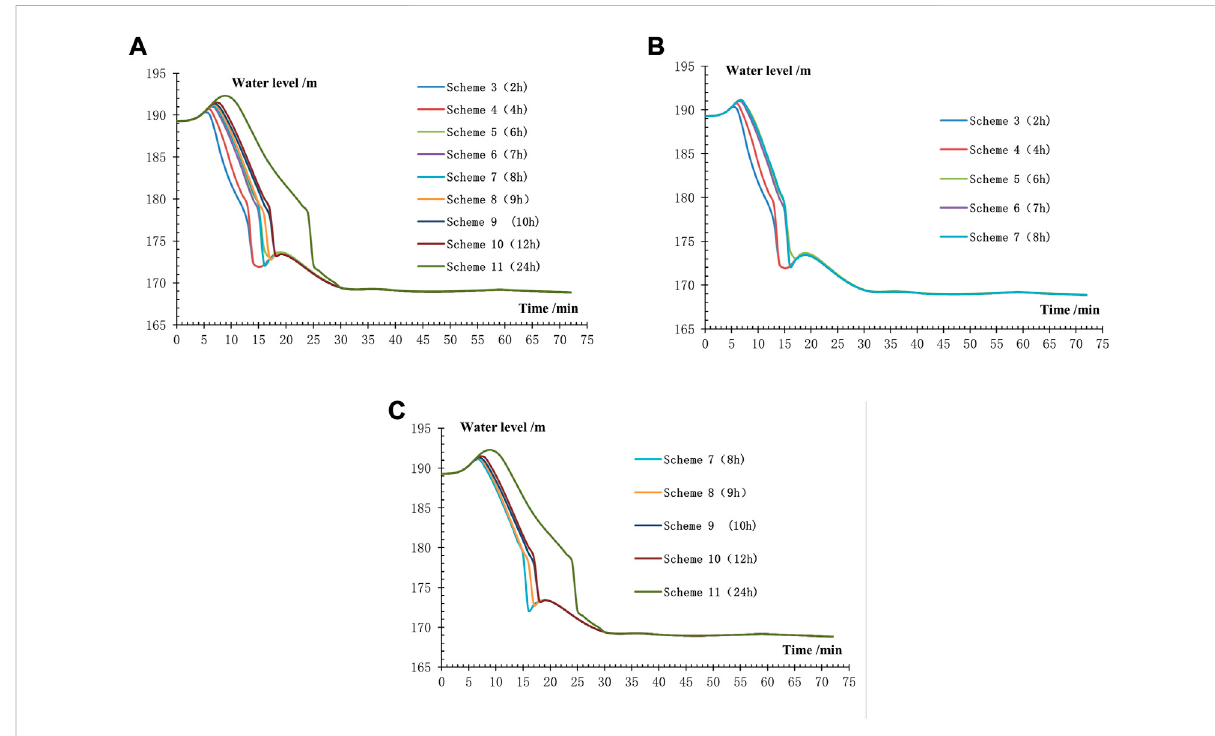
FIGURE 3 Hydrograph of the water level in front of the dam.